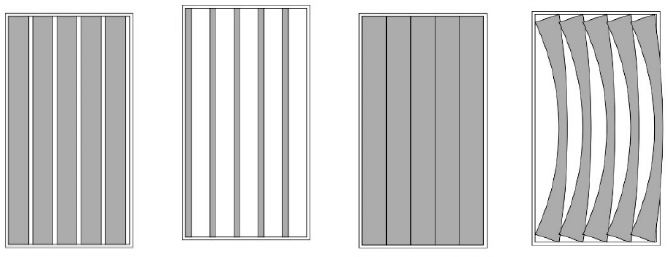
Figure 3. Schematic illustrations of some Bio-ABS examples, from left to right; the Ocean Pavilion in closed and open configurations, and Flectofin ™ in closed and open configurations.